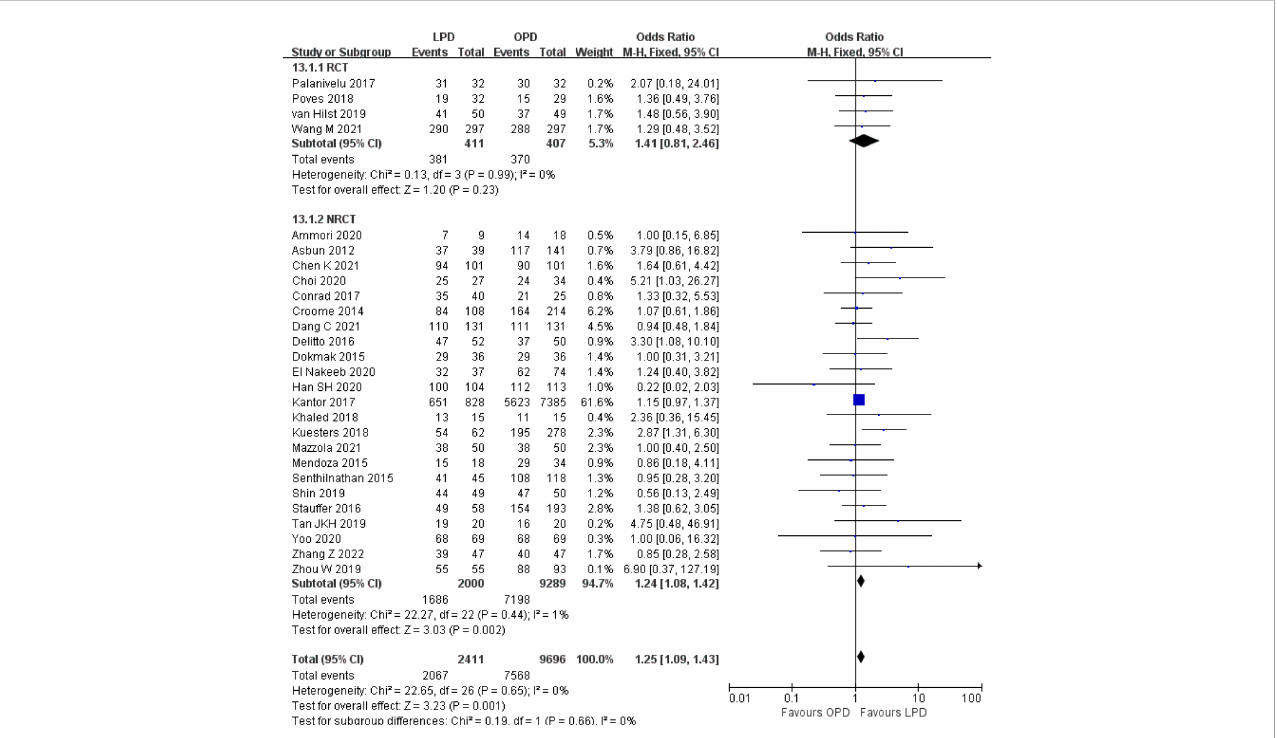
FIGURE 13 Forest plot of comparison between LPD and OPD on R0 resection. LPD, laparoscopic pancreaticoduodenectom; OPD, open